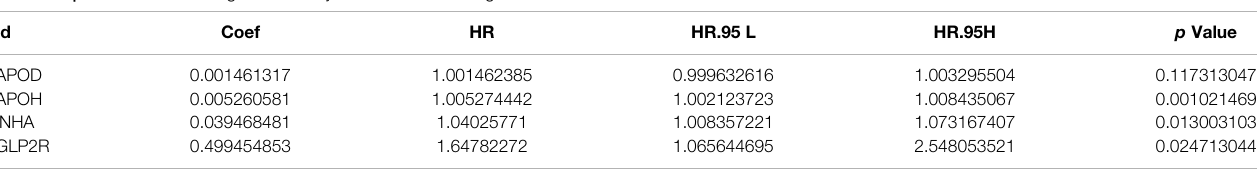
TABLE 2 | Multivariate COX regression analysis results of model